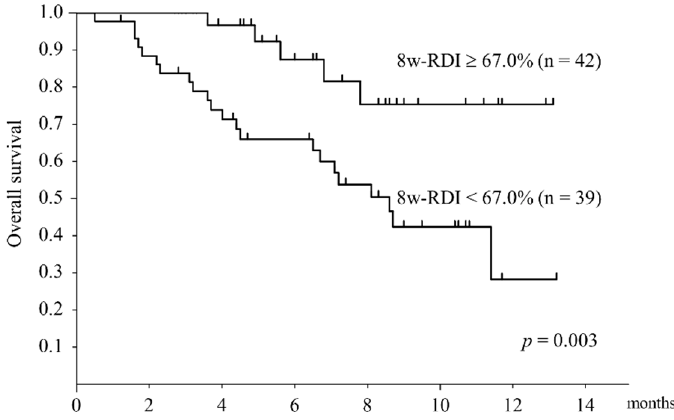
Figure 6. Overall survival stratified by relative dose intensity at 8 weeks. Kaplan–Meier curves stratified by an 8-week RDI of 67.0%. There was a significant difference in overall survival (OS) between the two groups. Table 5. Comparison between two groups with relative dose intensity.